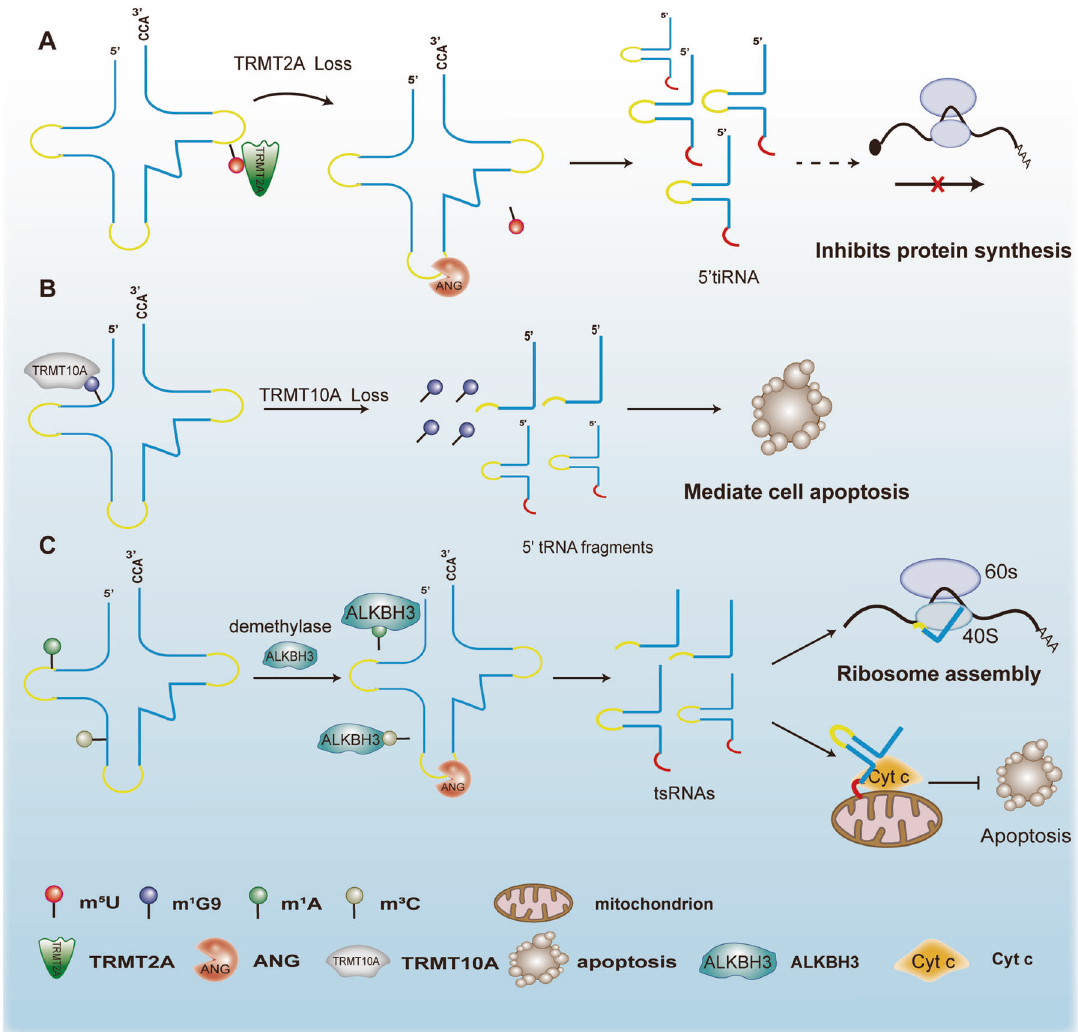
Fig. 2 Regulation of tsRNA production. A Deletion of the methyltransferase, TRMT2A, induces ANG-dependent production of 5 ’ tiRNA and inhibits the protein synthesis. B The lack of the TRMT10A methyltransferase leads to hypomethylated tRNA cleavage to produce a 5 ’ tRNA fragment that mediates cell apoptosis. C In the presence of the ALKBH3 demethylase, tRNA hypomethylation produces tsRNAs that can bind to the 40s ribosome to facilitate ribosomal assembly and interact with cytochrome c to inhibit apoptosis,